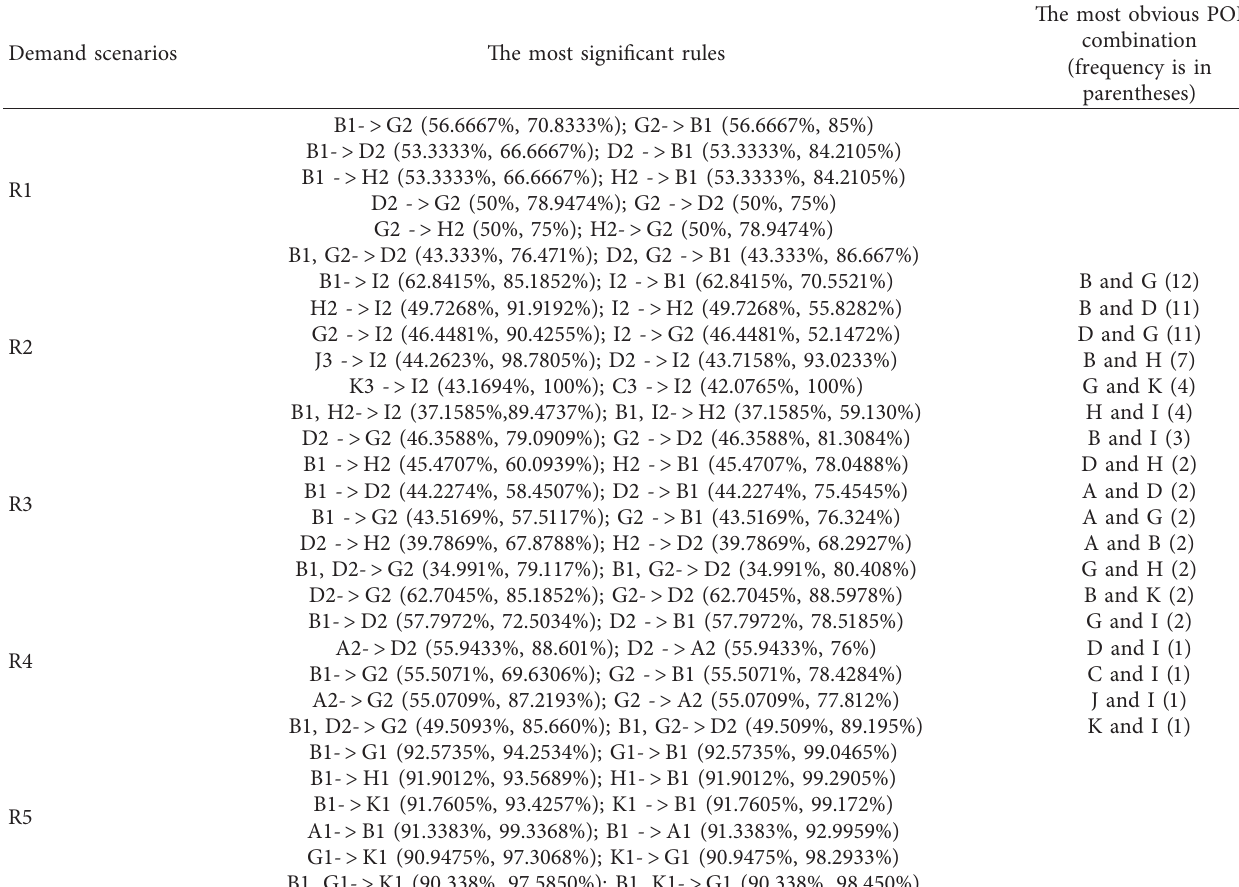
Table 8: The statistics of rules from Model